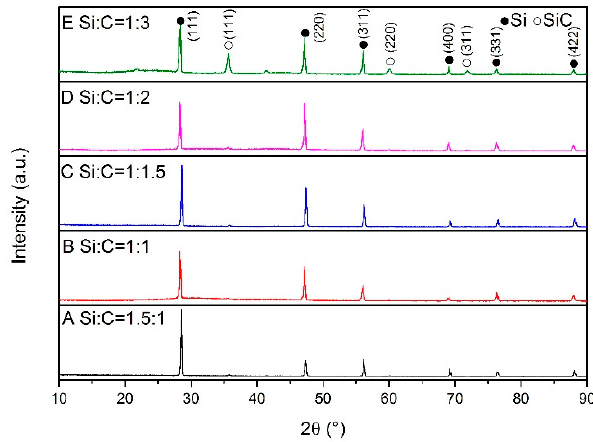
Figure 1. XRD patterns of samples with different Si/C ratios synthesized at 1350 °C.